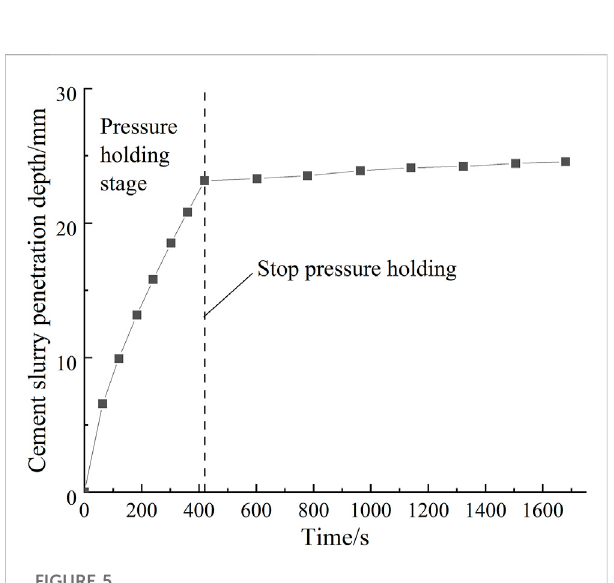
FIGURE 5 Variation in cement slurry penetration depth with